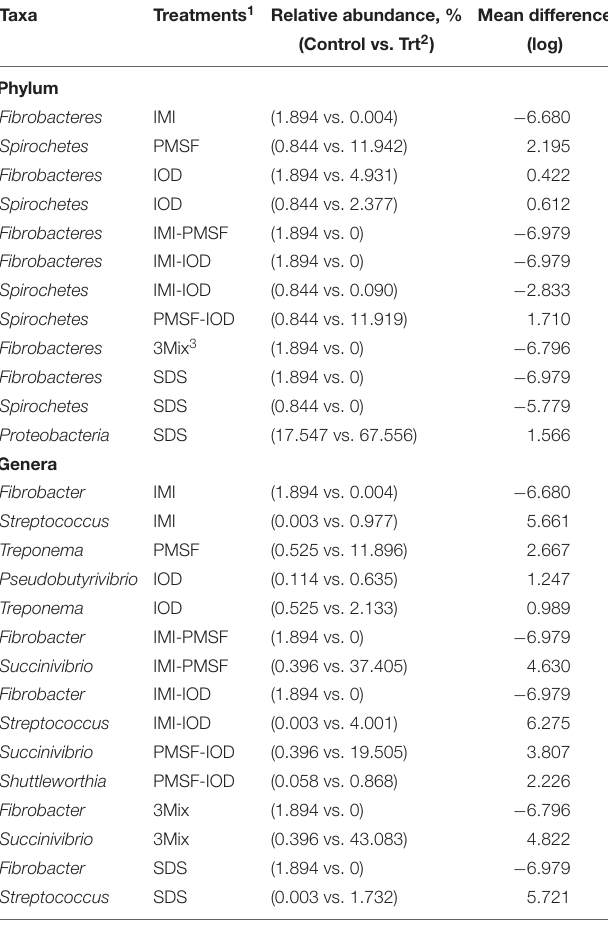
TABLE 3 | Major differentially abundant bacterial phyla and genera (each representing > 0.5% of total sequences in at least one of the treatments) defined by ANCOM between the controls and each inhibitor